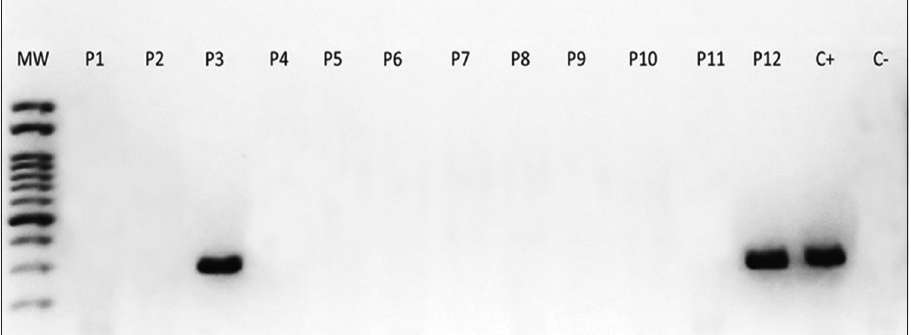
Figure-6: Reverse transcription polymerase chain reaction of adipose stem cells from dogs infected with canine distemper virus. P3 and P12: Positive samples displaying similar bands as C+. C+: Positive control. C−: Negative control. MW=Molecular weight